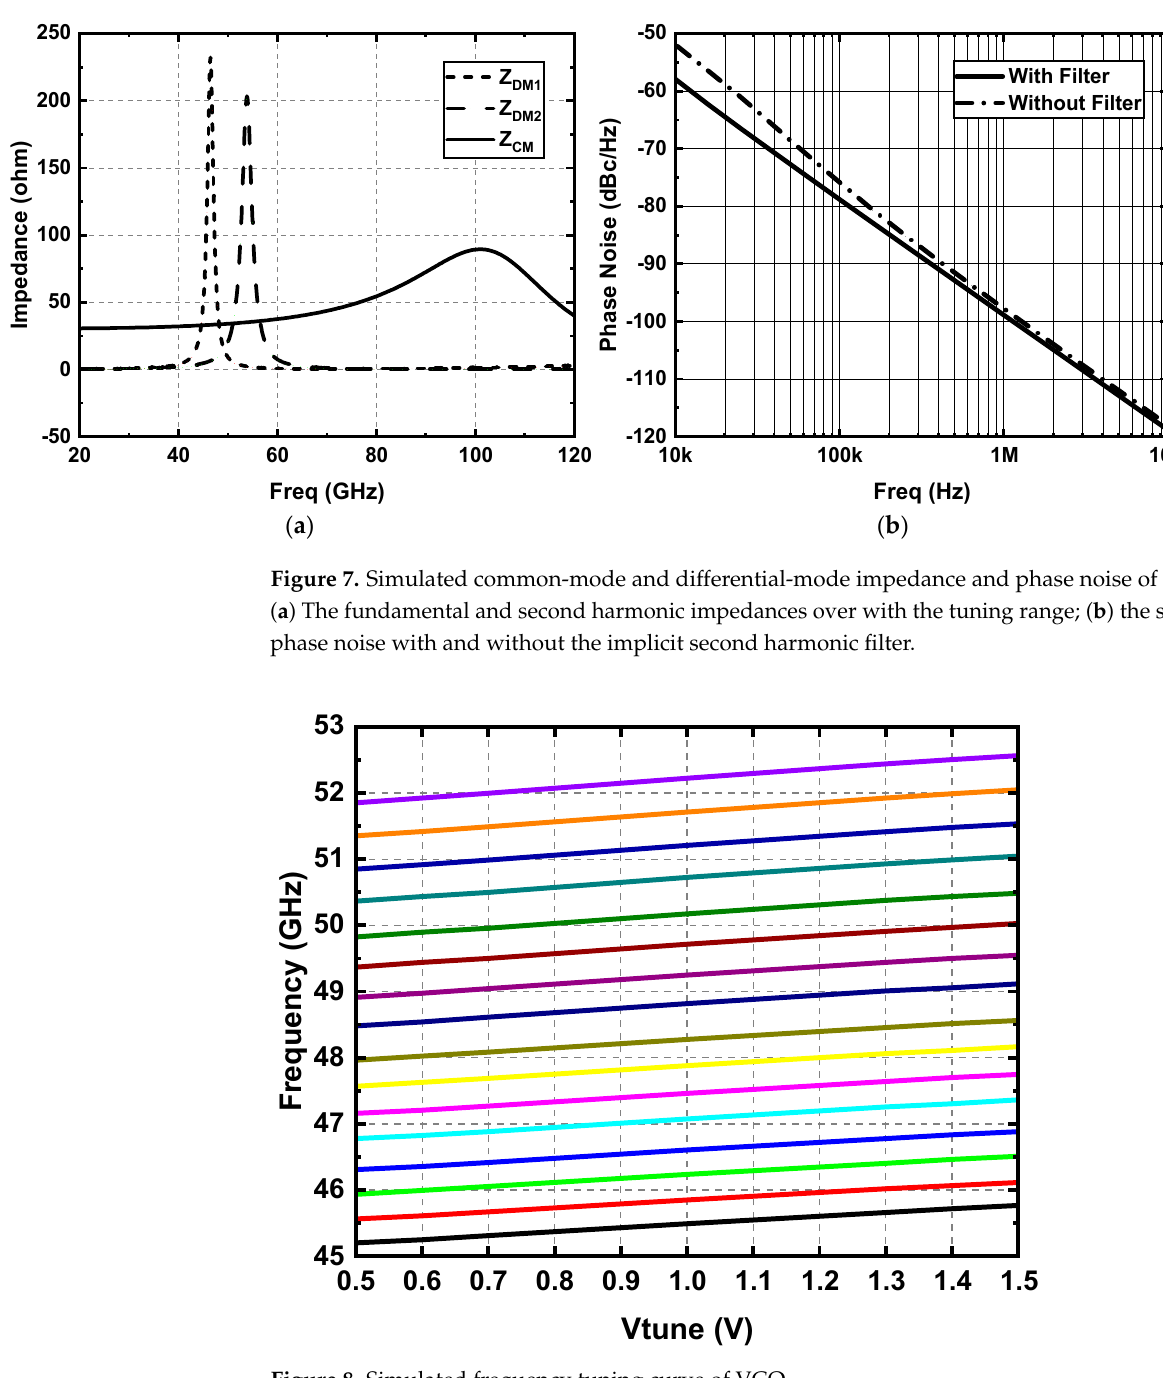
Figure 8. Simulated frequency tuning curve of VCO.